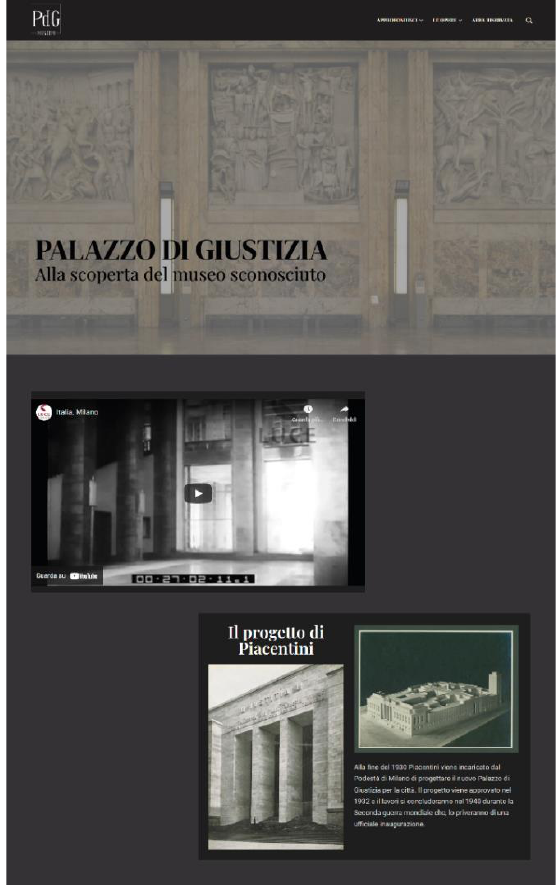
Fig 19. A part of the homepage of the website.